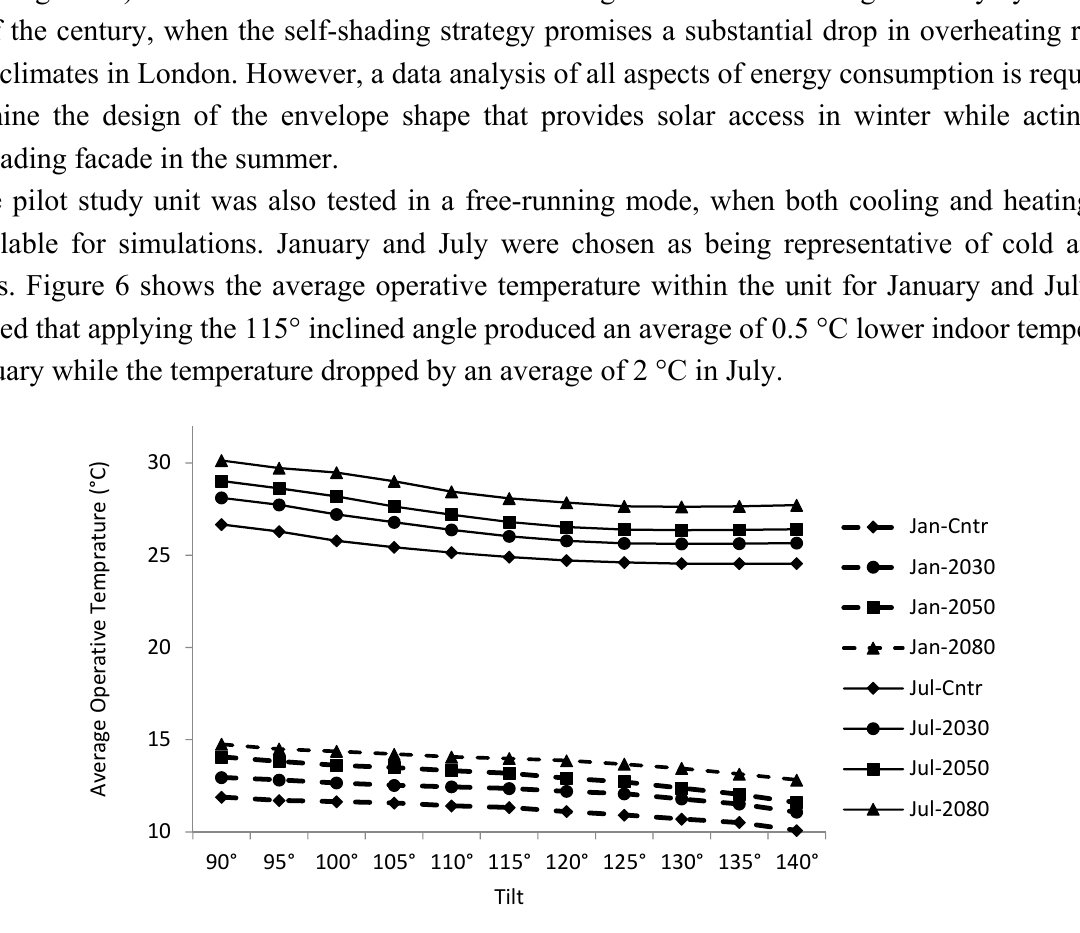
Figure 6. Average indoor operative temperatures for free-running Passivhaus pilot unit in January and